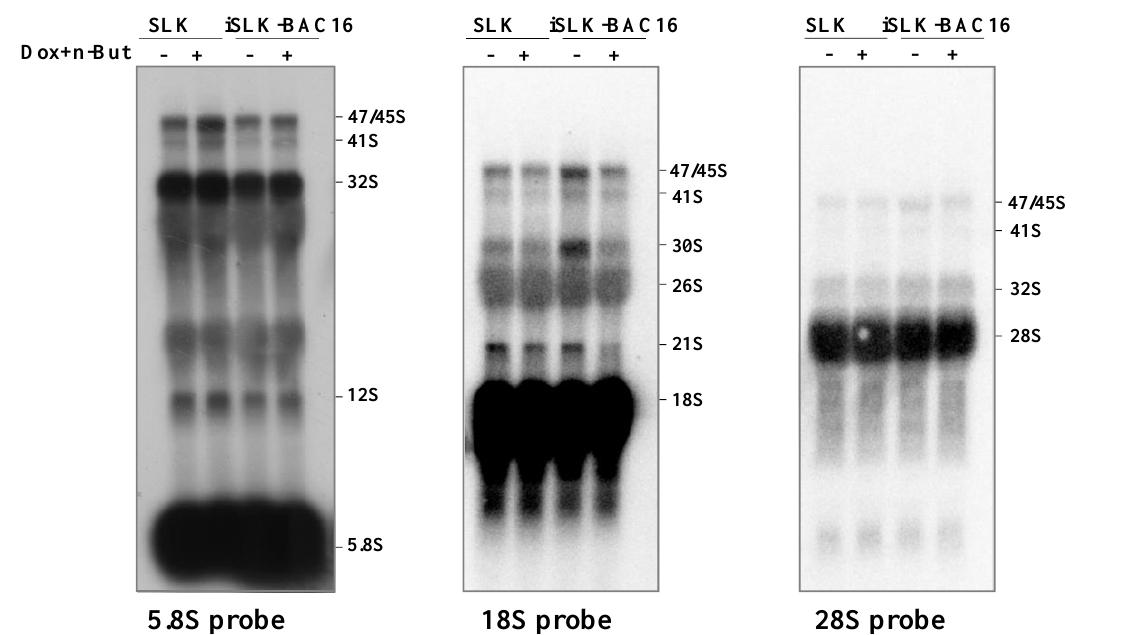
Figure 7. Northern blot analysis of rRNA during viral lytic reactivation. Total RNA was extracted from uninfected SLK and BAC16-mCherry-ORF45-infected iSLK cells that were either left untreated or treated with Dox and n-Butyrate for 48 h. Lytic reactivation was confirmed by the expression of mCherry-ORF45 in ~70% of cells. A total of 20 µg RNA from each sample was resolved on denaturing 1.2% agarose gel, transferred to nylon membranes, and hybridized with probes representing 5.8S, 18S and 28S rRNA. No accumulation of pre-rRNA processing products was evident upon lytic reactivation.